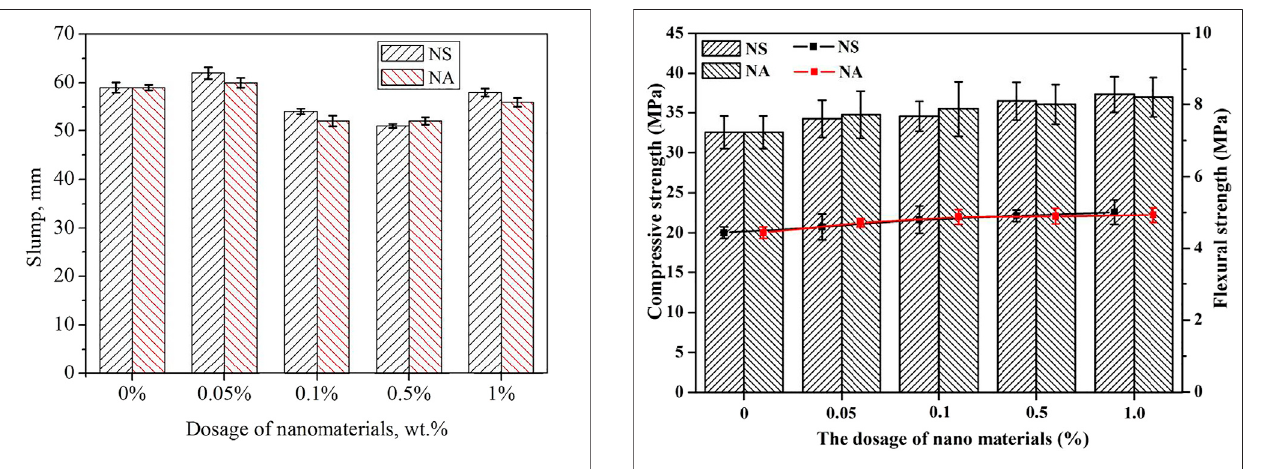
FIGURE 2 | Mechanical properties of concrete as a function of the dosage of